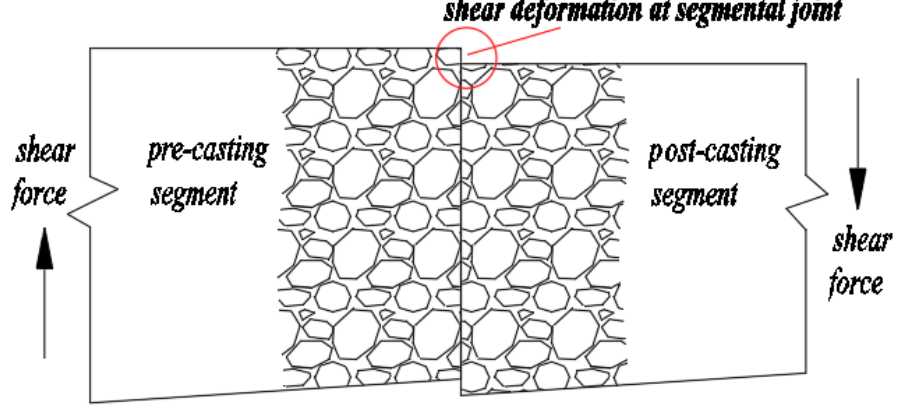
Figure 1. Schematic diagram of the shear deformation at segmental joints.